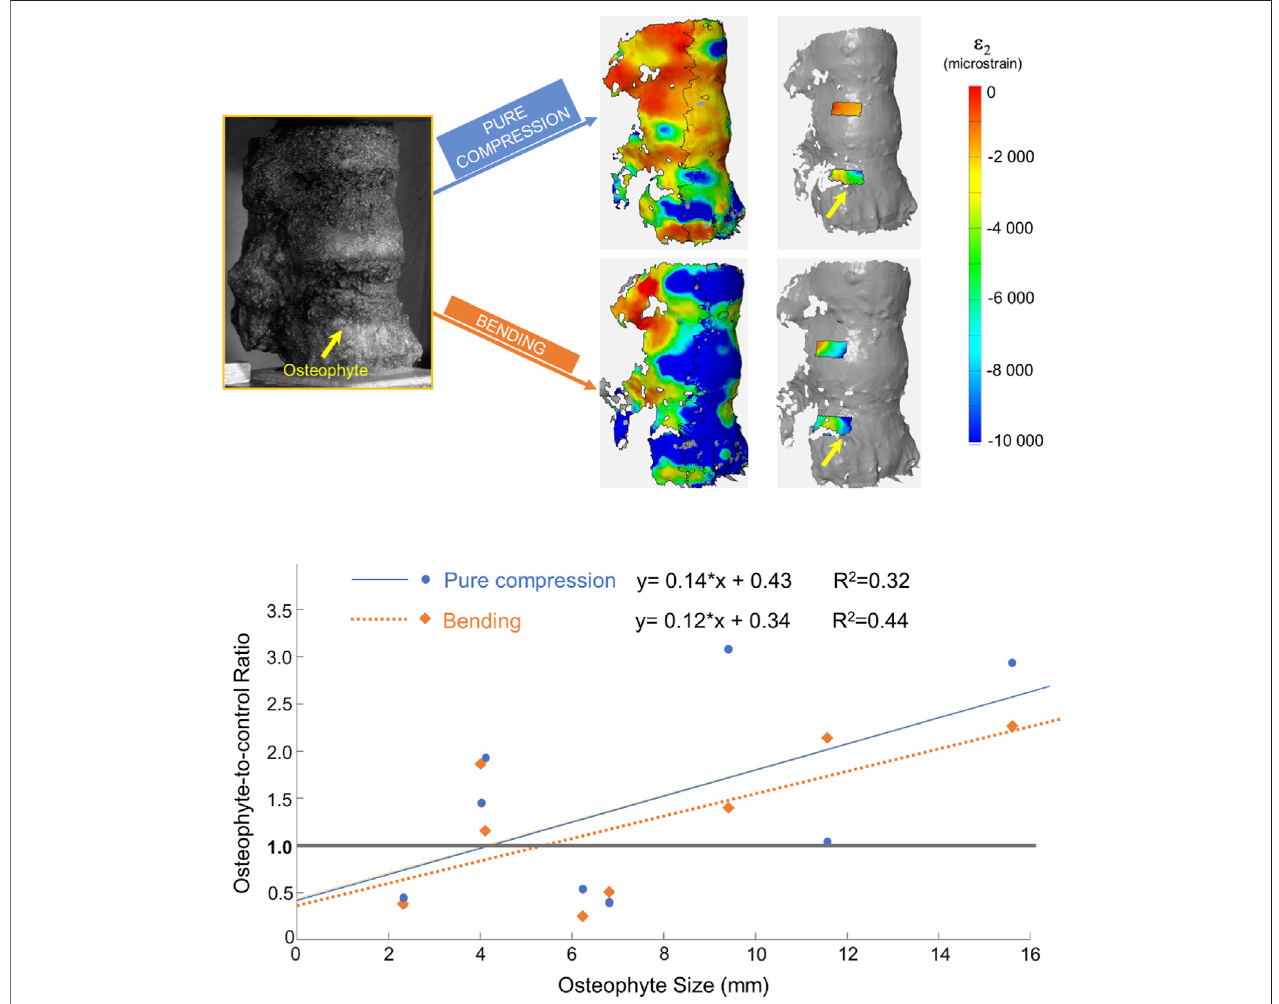
FIGURE 3 | Top: from left to right: image taken by the DIC cameras, full- fi eld minimum principal strains, and minimum principal strain measured in the ROIs for the twoloadingcon fi gurations. Inalltheimages,thespecimenisviewedfrom theright-anterior side.Theyellow arrowhighlightsthepositionoftheosteophyte. Bottom:plot and linear regressions between the osteophyte-to-control ratioand the osteophyte sizeunder two different loading con fi gurations. The gray line in thegraph depicts the condition in which the two ROIs in the same specimen have the same deformation.